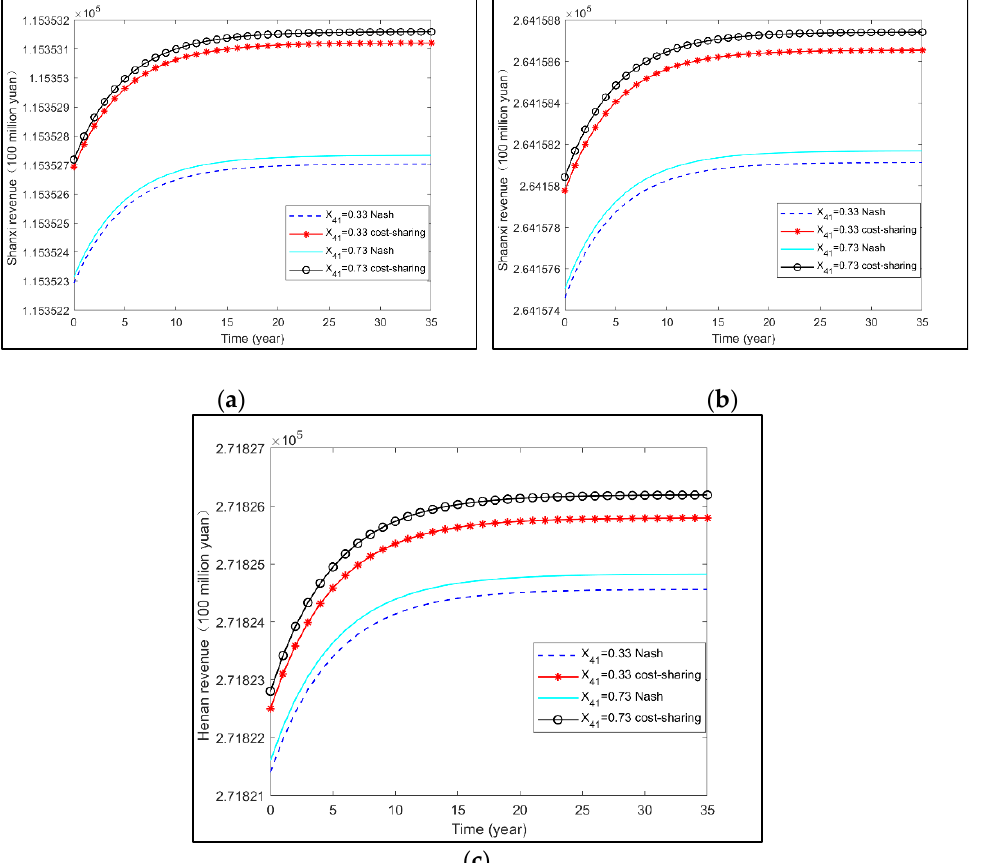
Figure 14. The effects of Shanxi province’s X 41 on each government’s revenues: ( a ) the Shanxi province government’s revenues, ( b ) the Shaanxi province government’s revenues, and ( c ) the Henan province government’s revenues.